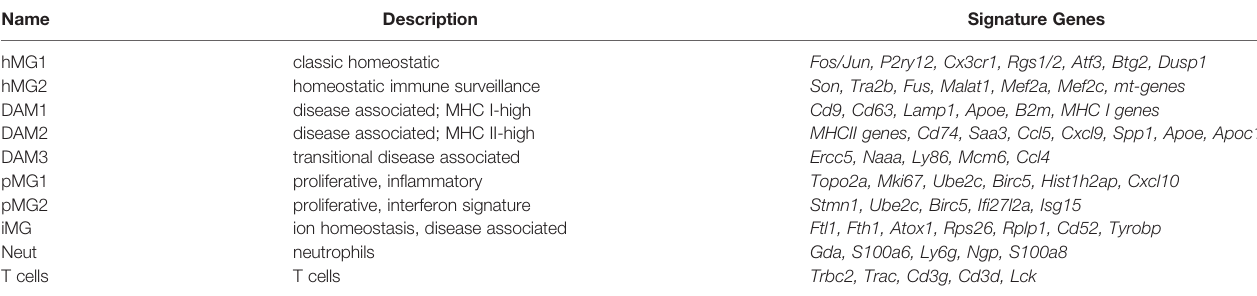
TABLE 1 | Signature marker genes of microglial states and other cell types identi fi ed by scRNAseq analysis in